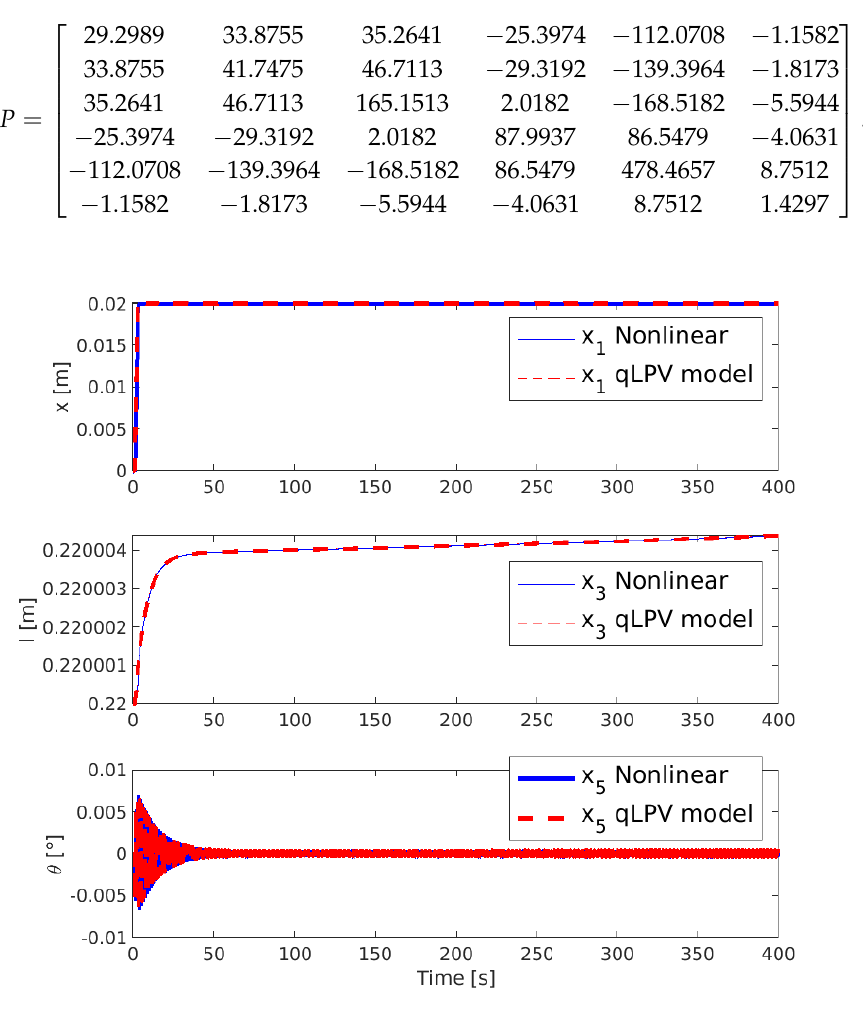
Figure 3. Comparison between the nonlinear and the quasi-Linear Parameter Varying (qLPV)